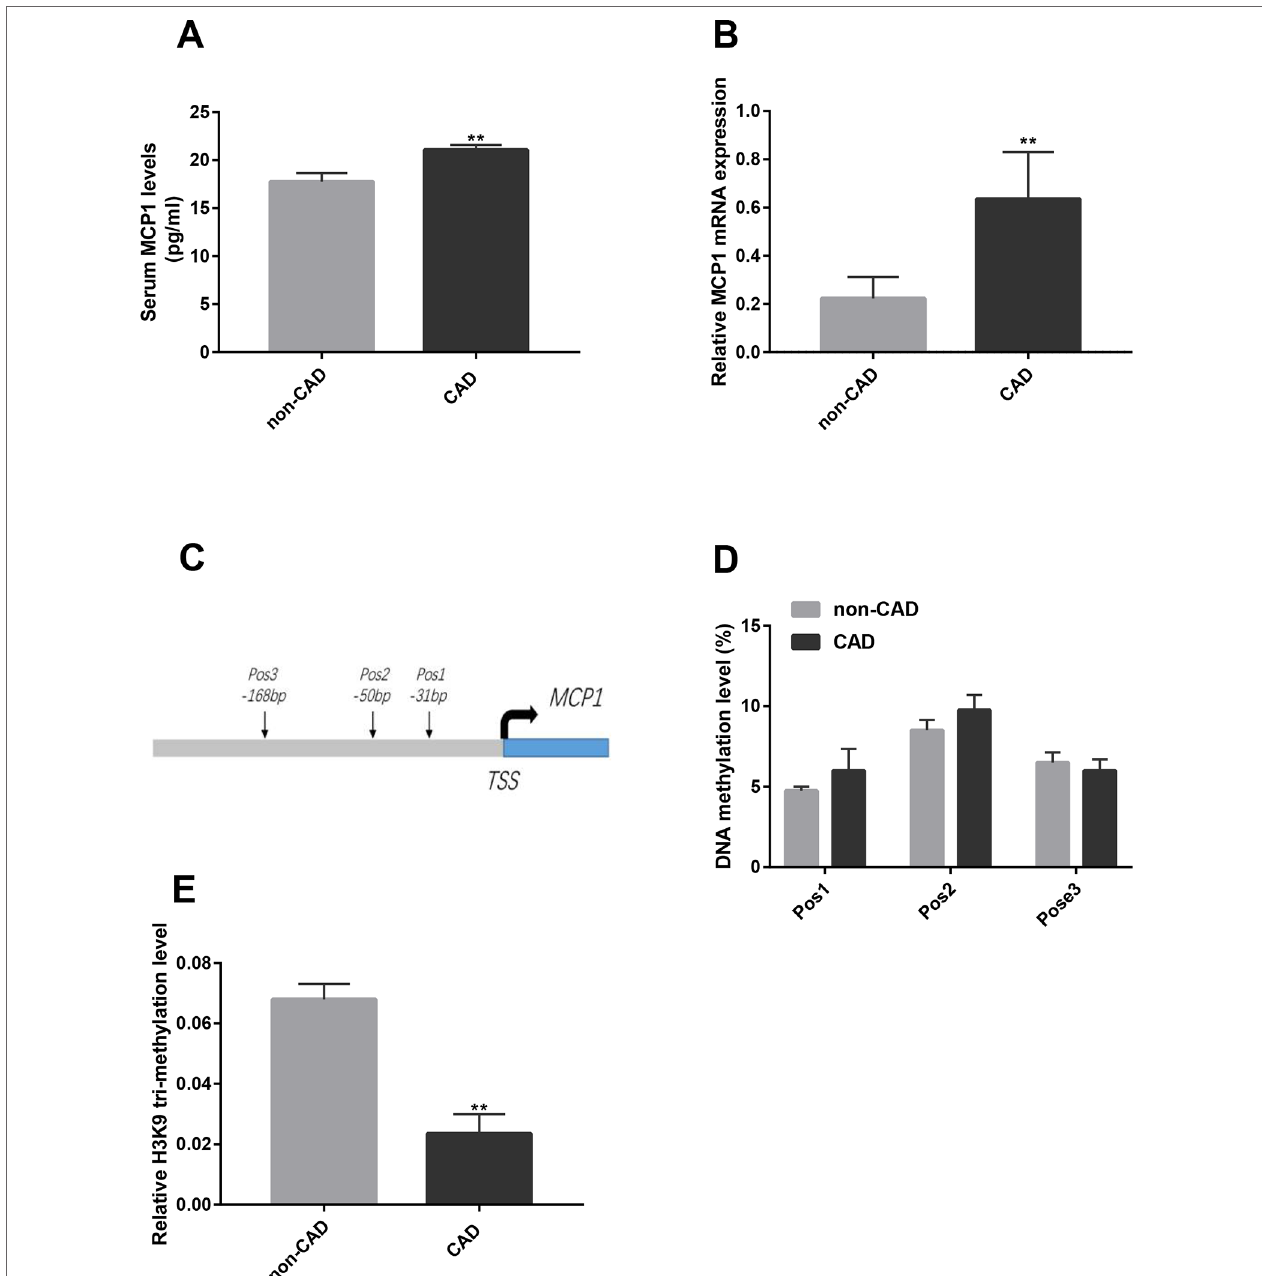
FigURE 1 | Expression and epigenetic modifications of MCP1 gene in CD14+ monocytes from CAD patients. (a) The concentration of MCP1 in the plasma of CAD (n = 13) and non-CAD (n = 8) patients was detected by ELISA. (B) The mRNA expression of MCP1 in CD14+ monocytes from CAD (n = 17) and non-CAD (n = 19) patients was determined by RT-qPCR. (C) A genomic diagram to indicate the genomic locations of CG pairs detected by pyro-sequencing. (D) The mean methylation level of the MCP1 gene promoter in CD14+ monocytes from CAD patients and non-CAD controls was measured by bisulfite sequencing (n = 4). (E) ChIP-qPCR analysis was used to detect relative histone H3K9 tri-methylation level of the MCP1 gene promoter in CD14+ monocytes from CAD patients and non- CAD controls (n = 3). The data shown are the mean ± SEM. ** P 0.01 relative to the